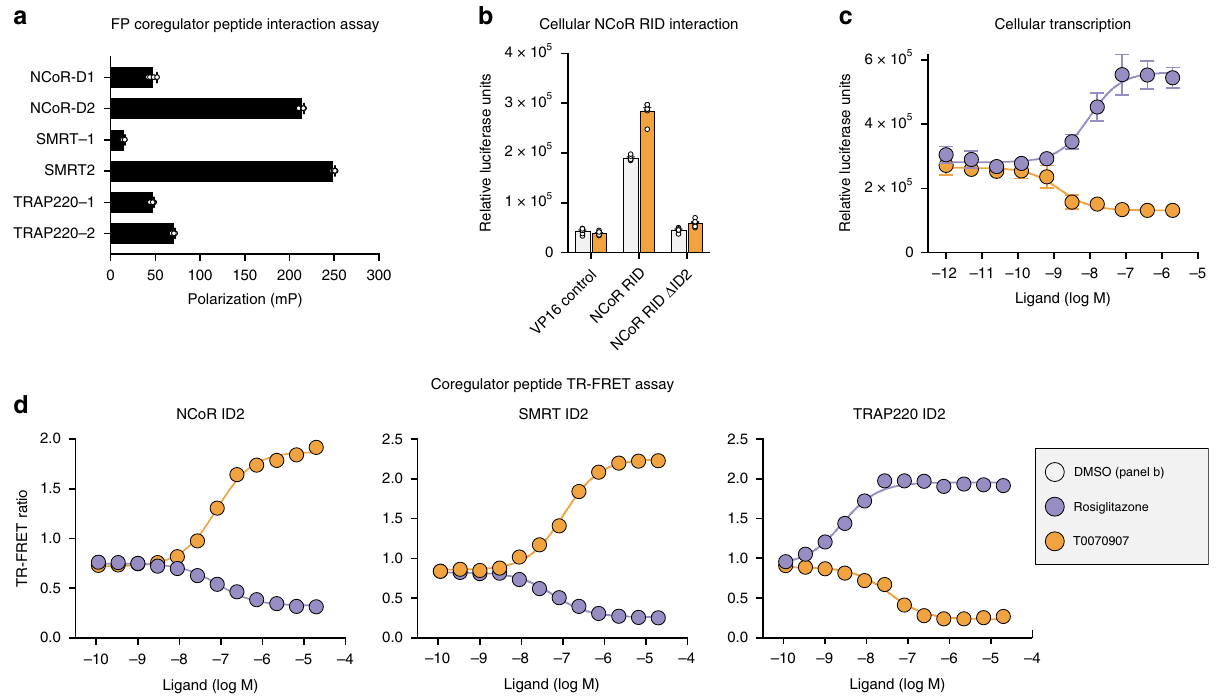
Fig. 1 PPAR γ interacts with the transcriptional corepressor ID2 motif. a Fluorescence polarization coregulator interaction assay shows a robust interaction between PPAR γ LBD with corepressor ID2 peptides from NCoR and SMRT as well as a TRAP220 coactivator peptide ( n = 6). b Mammalian two-hybrid assay in HEK293T cells measuring the effect of T0070907 (10 μ M) on the interaction between the Gal4-PPAR γ LBD and the VP16-NCoR RID ( n = 6; mean ± s.d.). c Luciferase transcriptional reporter assay measuring the ligand-dependent change in PPAR γ transcription ( n = 4; mean ± s.d.). d TR- FRET biochemical assay measuring the ligand-dependent change in the interaction of PPAR γ LBD with SMRT ID2, NCoR ID2, and TRAP220 ID2 peptides ( n = 3; mean ± s.e.m.). Source data are provided as a Source Data fi le.